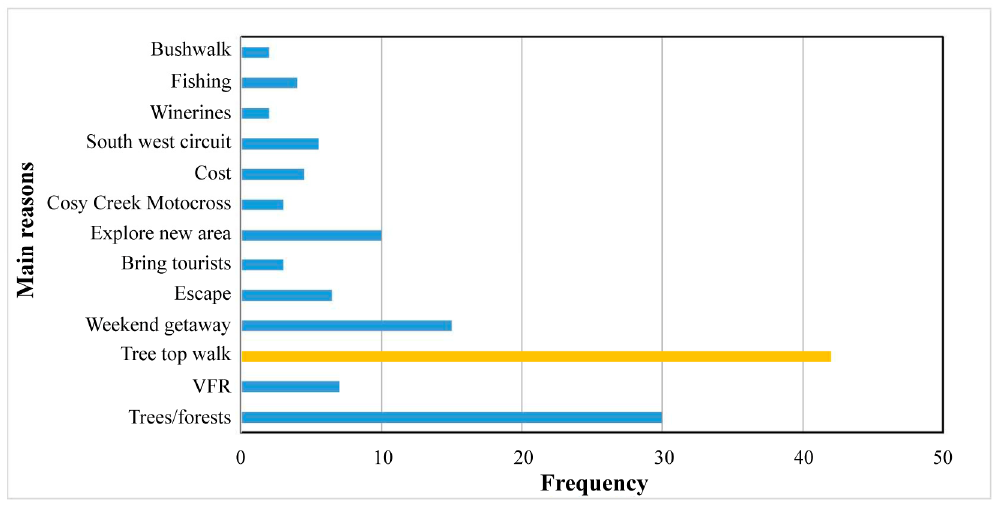
Figure 2. Reasons for visiting the Valley of the Giants (Source: author remade according to reference [38]).